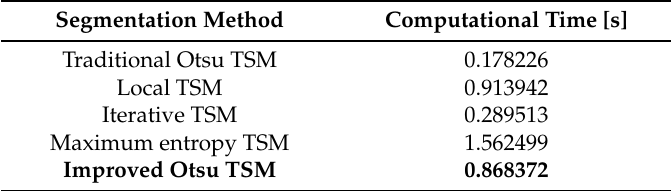
Table 3. Computational costs of different segmentation methods on Figure 1a.